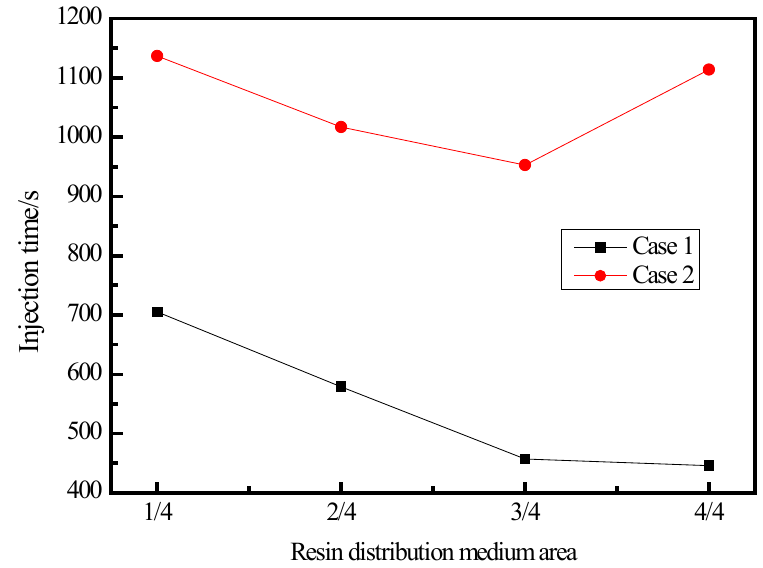
Figure 5. Resin flow time under different injection schemes.